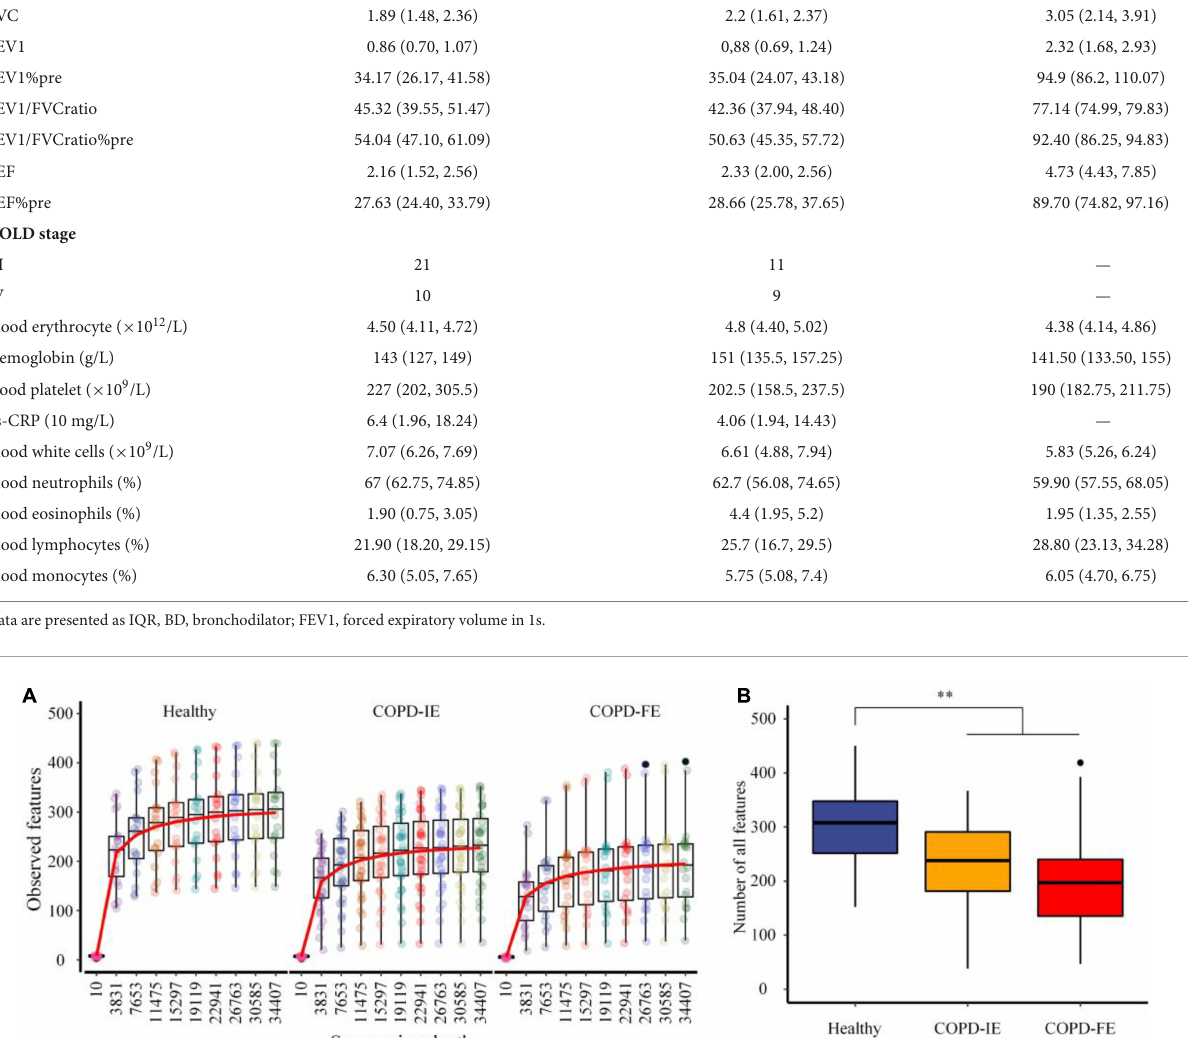
Supplementary Figure 2 ), implicating a different airway microbial assemblage between these two subgroups based on exacerbation frequency differentiation. Further characterization of the difference would provide new perspectives to explore unique features of frequent exacerbation